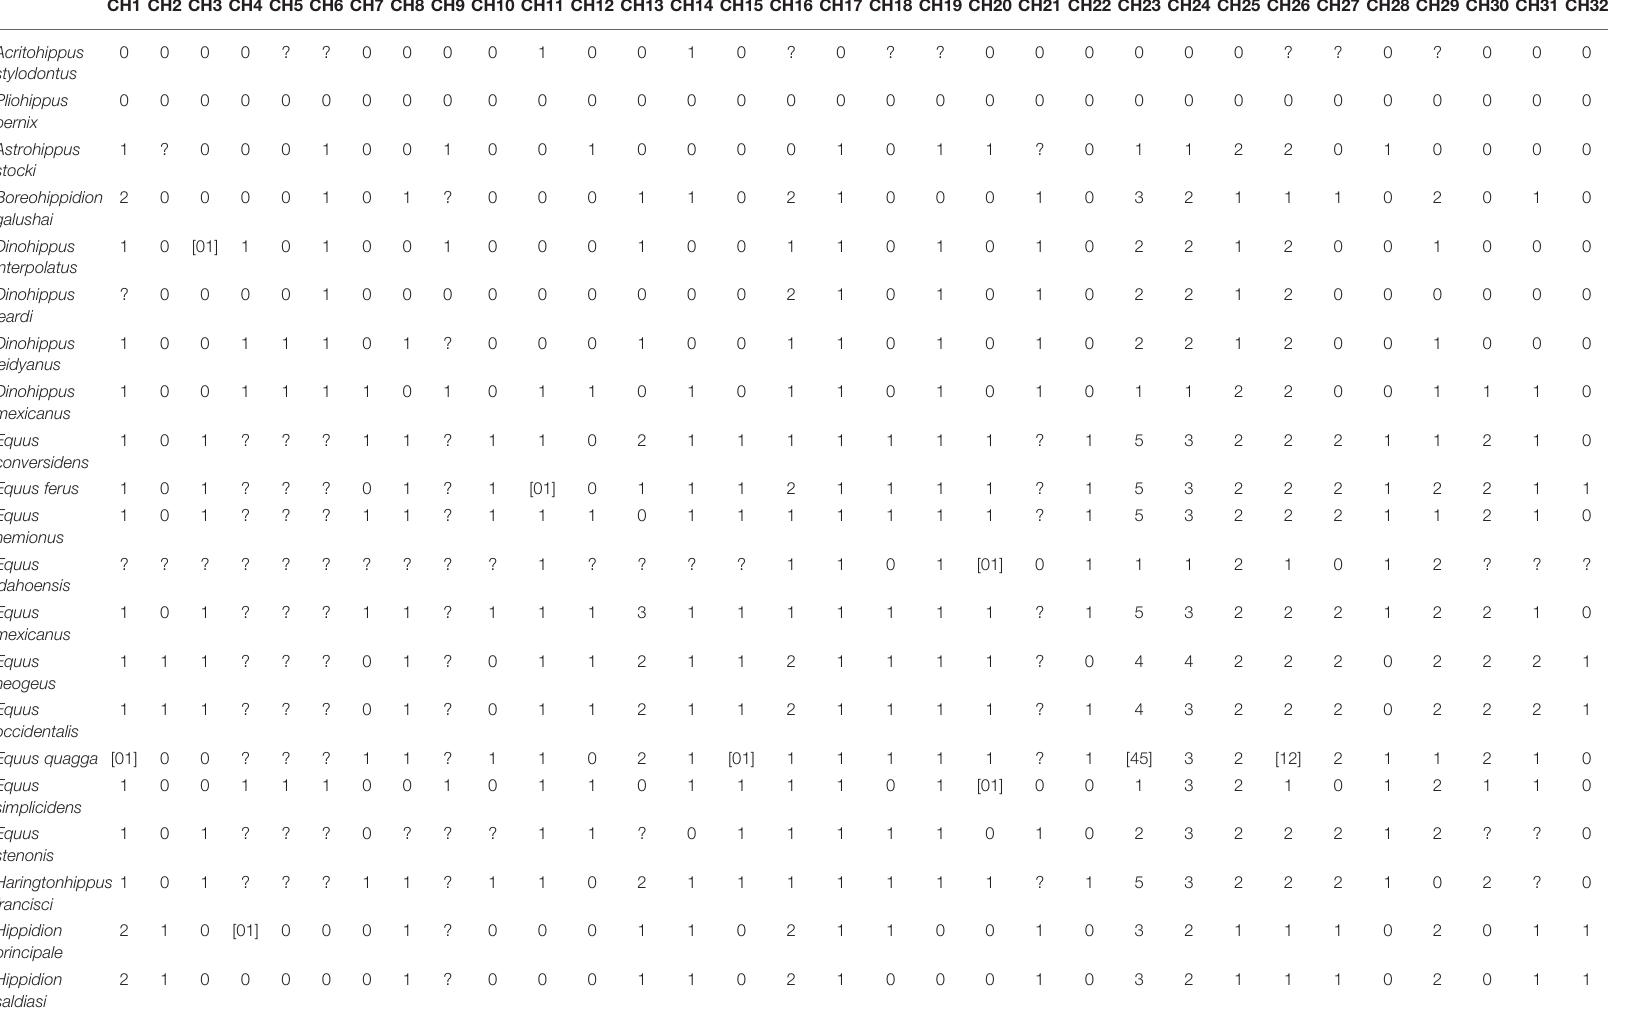
CH means character followed by the number of the character. The definitions of characters and their states are in the